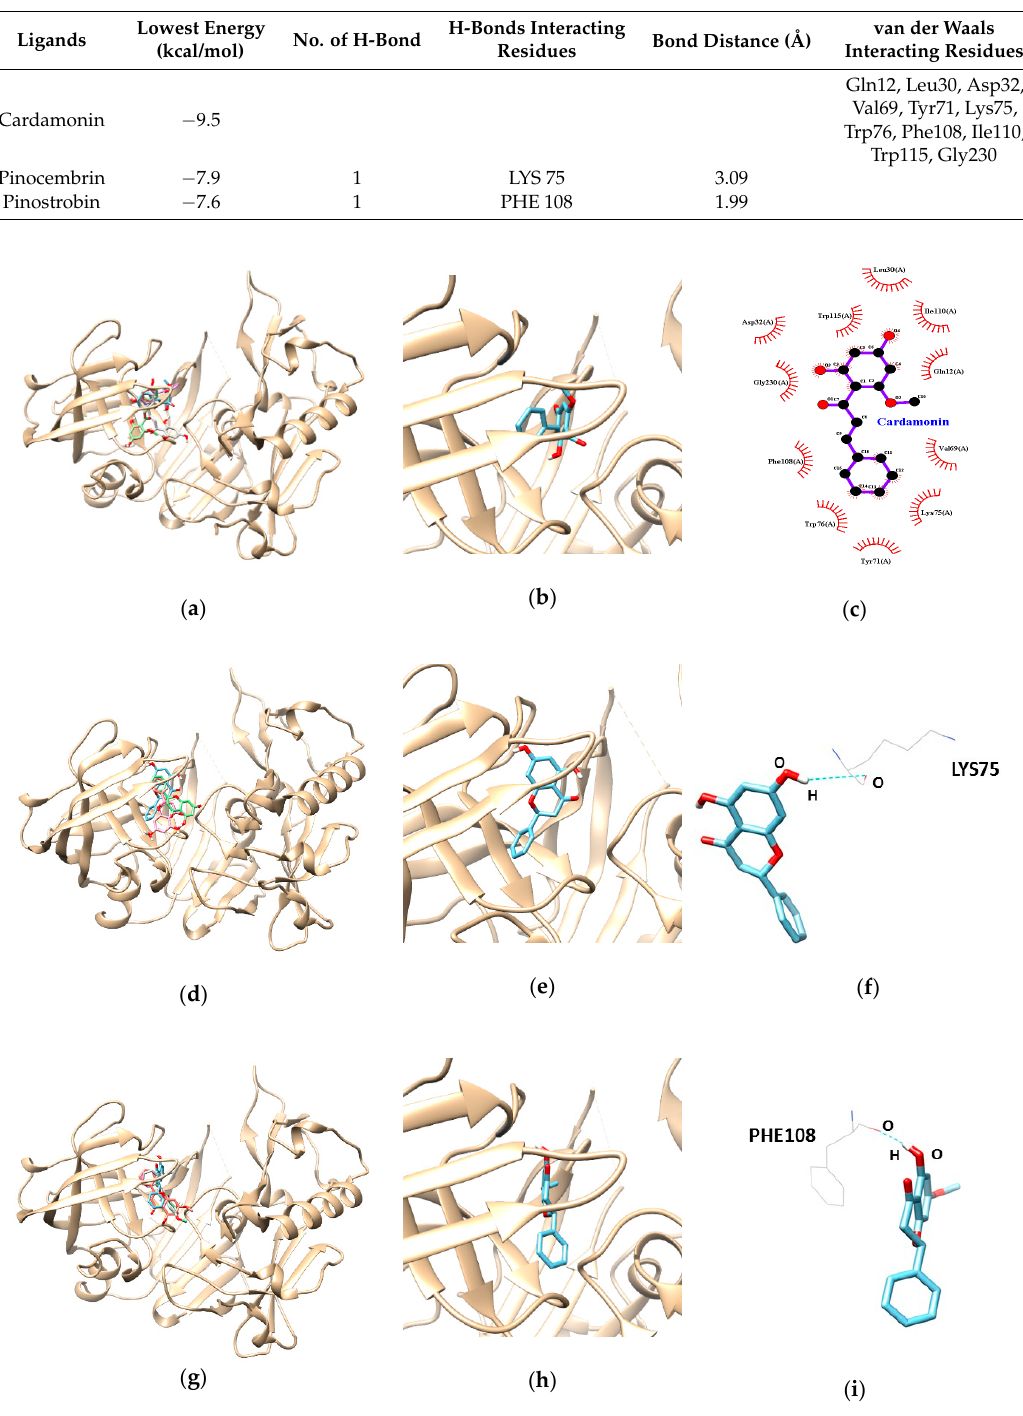
Figure 3. Molecular docking analysis of cardamonin, pinocembrin, and pinostrobin with BACE1. The best docking poses between BACE1 and cardamonin ( a ), pinocembrin ( d ), and pinostrobin ( g ). Magnified view of the binding site for cardamonin ( b ), pinocembrin ( e ), and pinostrobin ( h ). The hydrophobic interaction of cardamonin ( c ). Hydrogen interaction diagram of pinocembrin ( f ), and pinostrobin ( i ). The blue dotted lines show hydrogen bonds between ligands and